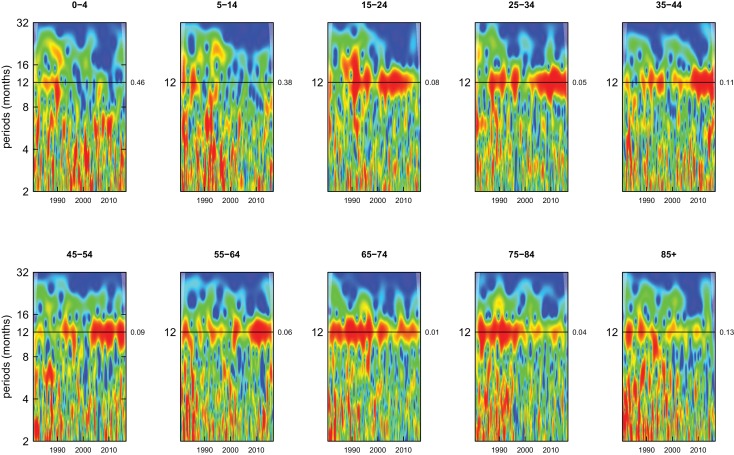
Wavelet power spectra for national time series of intentional injury death rates for 1980–2016, by age group for males.Wavelet power values increase from blue to red. The shaded regions at the left and right edge of each box indicate the cone of influence, where spectral analysis is less robust. P-values for the presence of 12 month seasonality are to the right of each figure at the 12 month line.